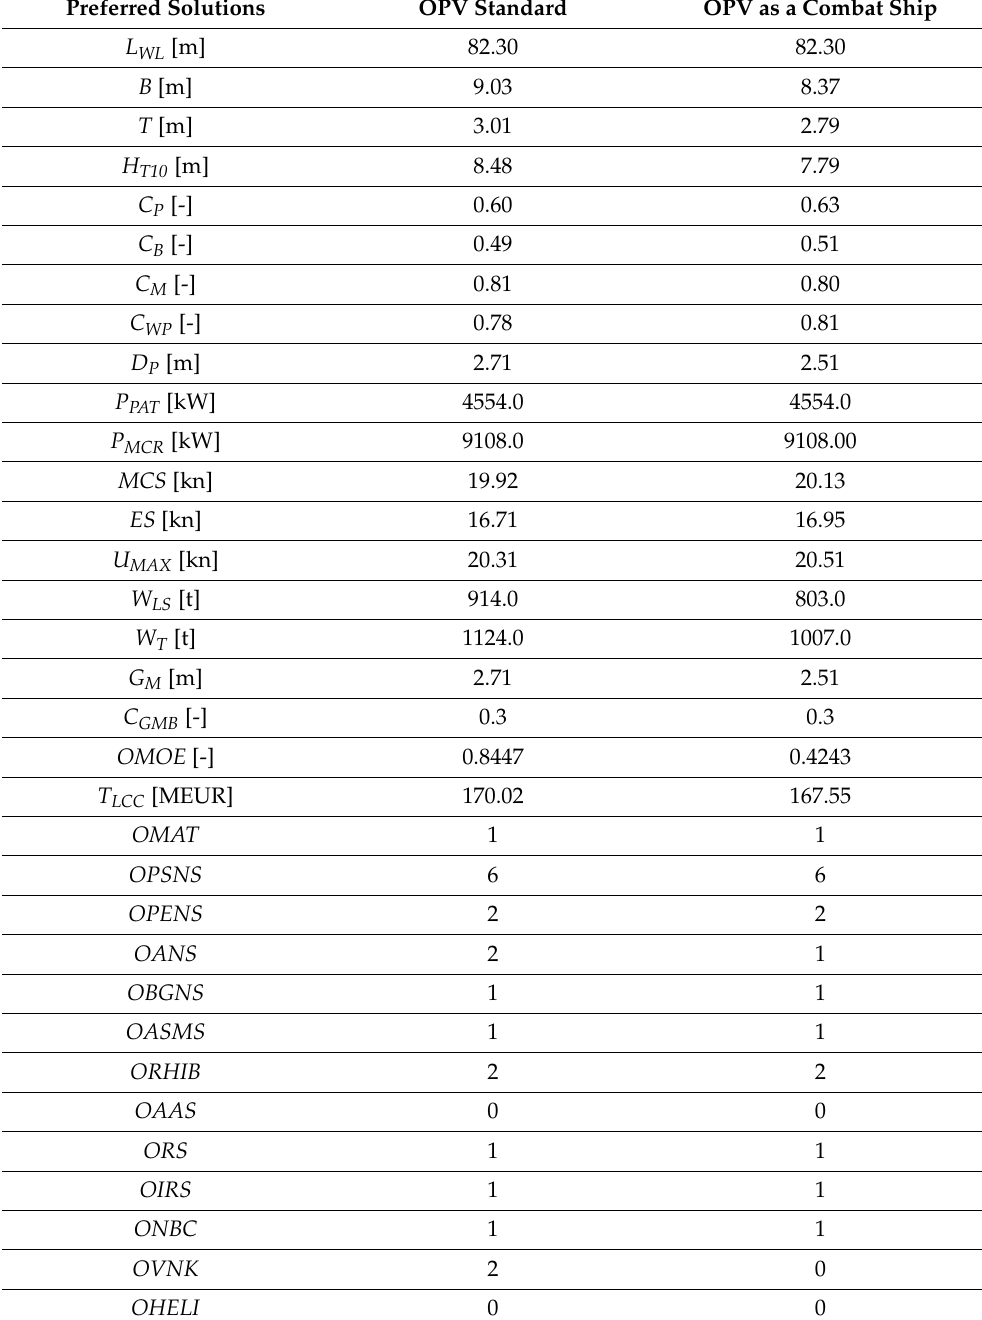
Table 4. Design parameters of selected preferred design